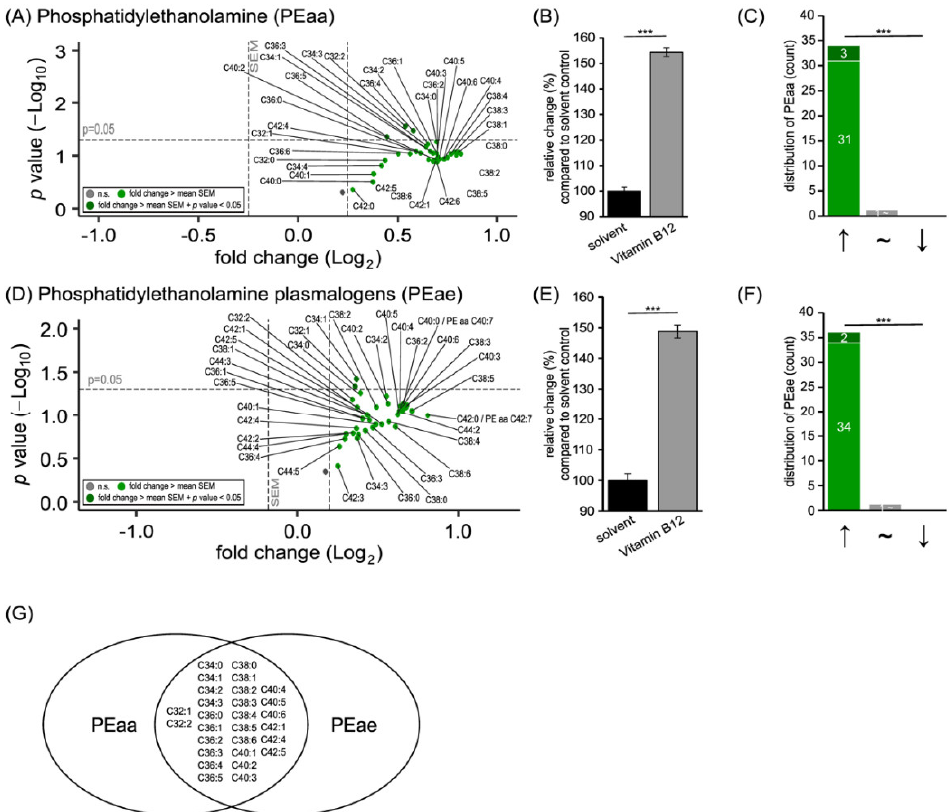
Figure 2. Effect of vitamin B12 treatment on phosphatidylethanolamine (PEaa) and phosphatidylethanolamine plasmalogens (PEae) species. SH-SY5Y cells treated with vitamin B12 compared to cells treated with the solvent control (HPLC water). ( A ) In the volcano plot, each PEaa species with its fold change (x-axis) in relation to its p -value (y-axis) is shown as a dot. Volcano plots are structured as in Figure 1. ( B ) The bar chart shows the relative fold change of all measured PEaa species after vitamin B12 treatment, in comparison to treatment with the solvent control. ( C ) Distribution of PEaa species structured according to the amount of increased, unchanged, or decreased PCaa species. Grey dots represent no significant changes. Light green dots represent a fold change which is greater than the mean standard error of the mean (SEM). Dark green dots represent a fold change which is greater than the mean SEM and, additionally, has a p -value smaller than 0.05. ( D ) Volcano plot showing the changes in PEae species due to vitamin B12 treatment. ( E ) Representation of the relative fold change of all measured PEae species in a bar chart. ( F ) Distribution of PEae species. Distribution structured as described in ( C ). ( G ) Venn diagram presenting overlapping PEaa and PEae species that underwent changes greater than the average SEM. Statistical significance was set as *** p ≤ 0.001.